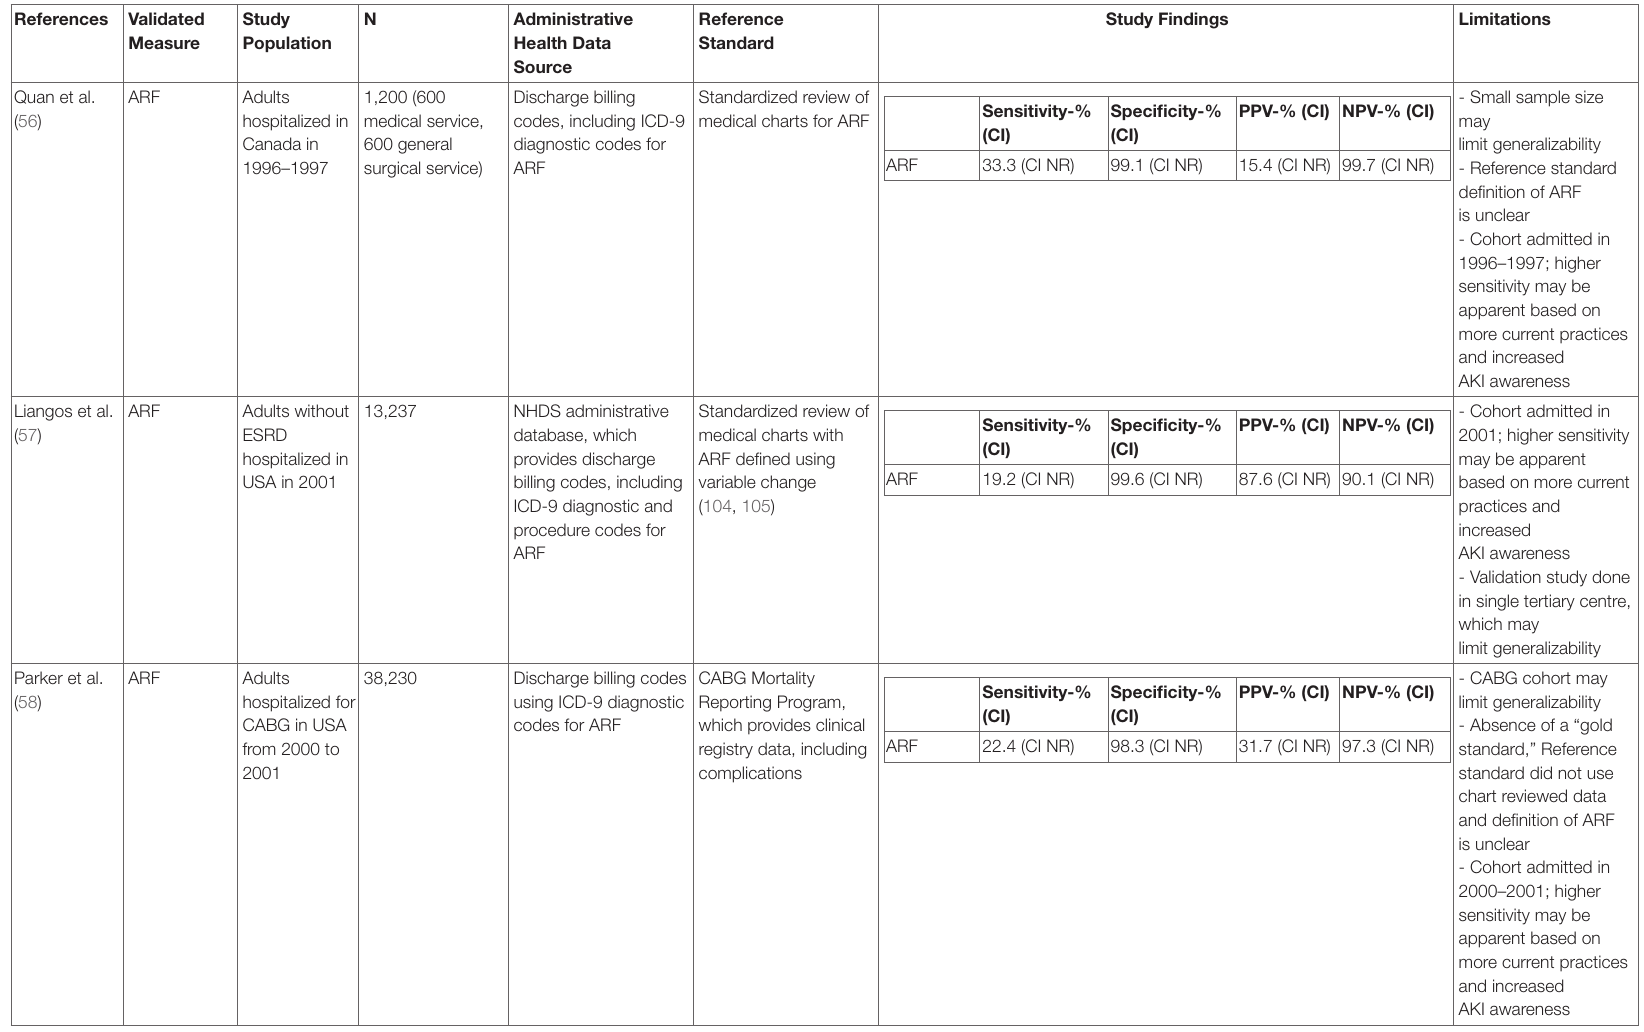
TABLE 2 | Summary of validation studies for acute kidney injury and renal replacement therapy codes in adults and pediatric administrative health